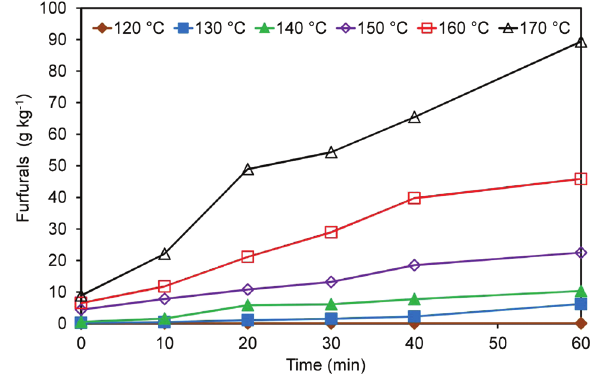
Figure 3: Effect of reaction temperature and holding time on the yield of